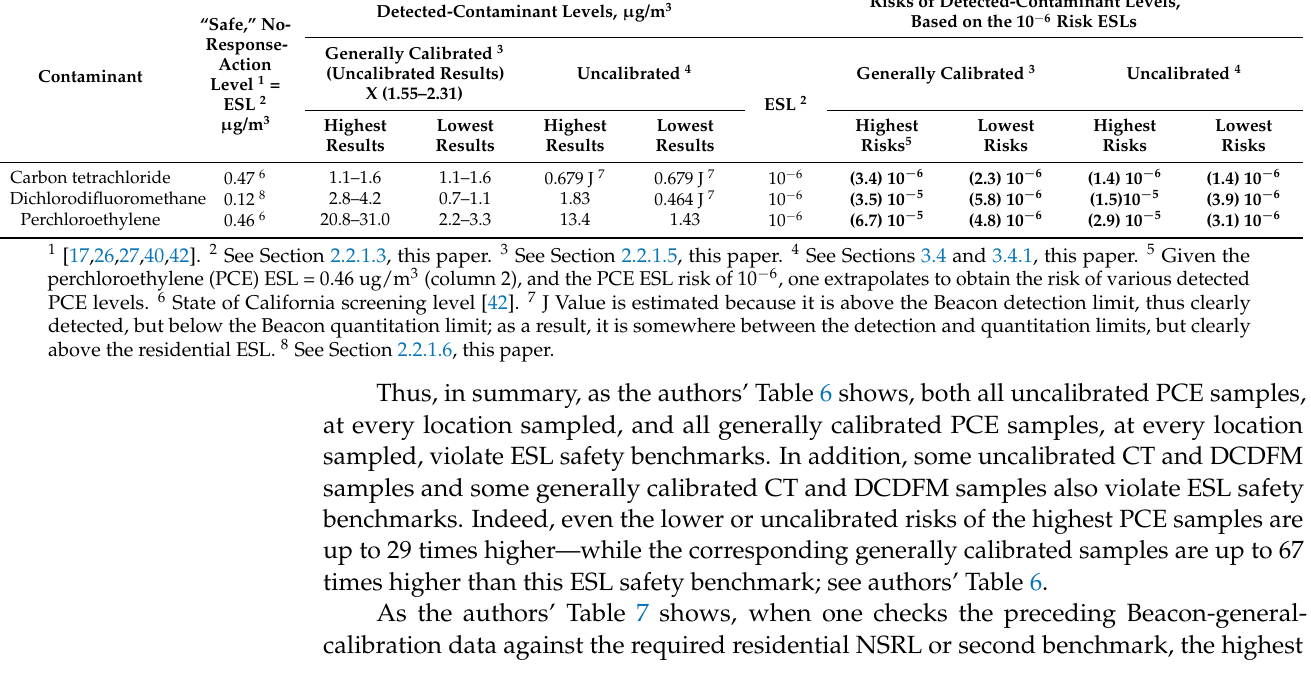
Sample Location